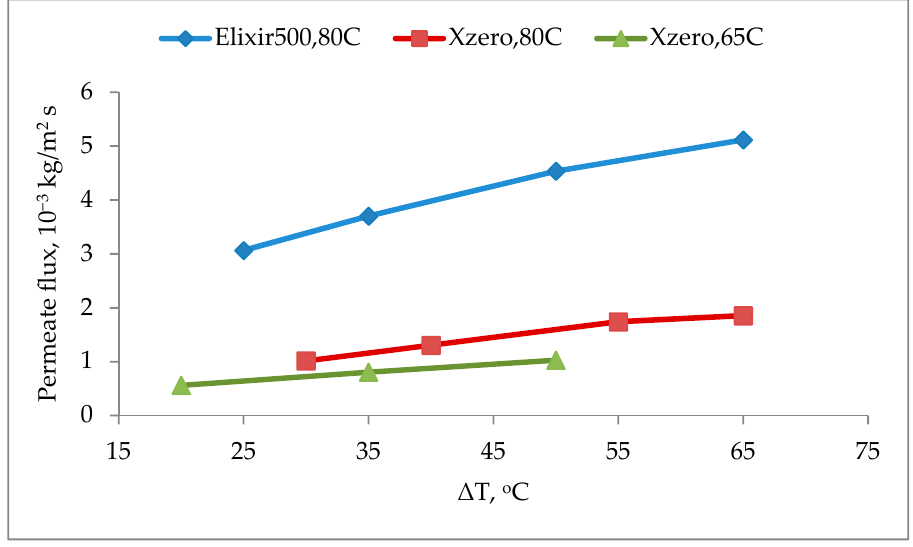
Figure 5. Permeate flux of Xzero and Elixir500 AGMD systems regarding permeate flux for different temperature differences at feed temperatures of 80 °C and 65 °C.